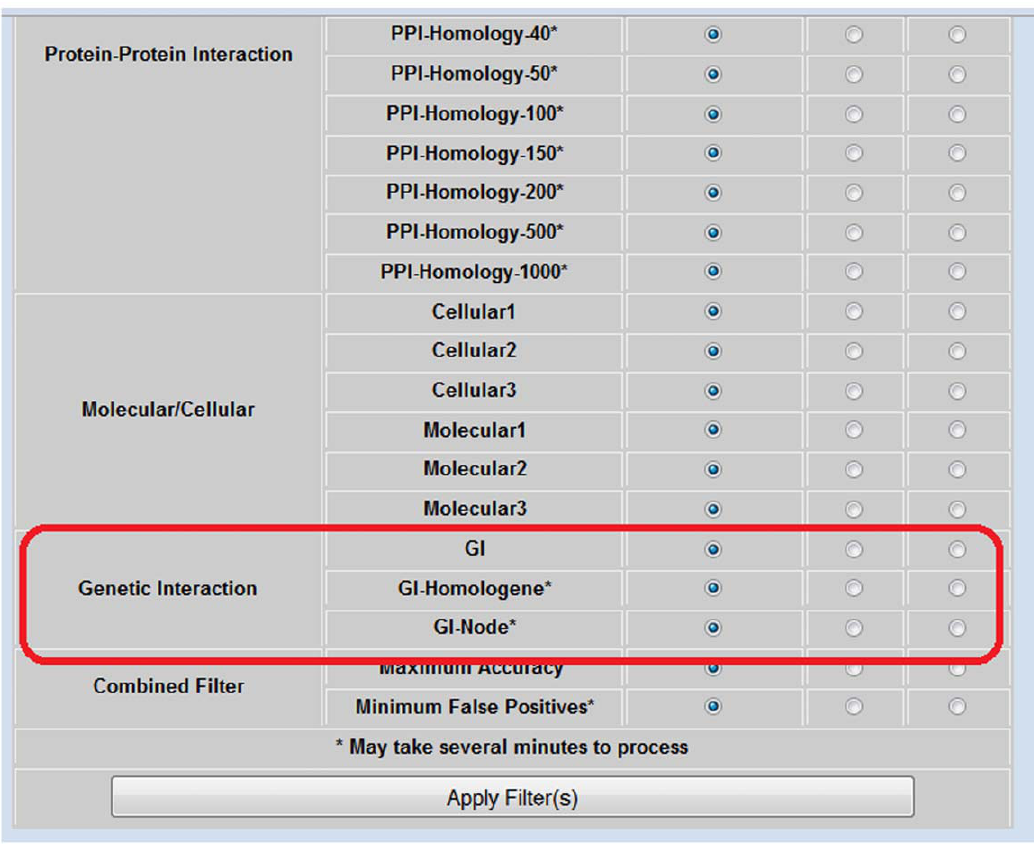
Figure 2. Screen Shot of Minimotif Miner 2.4 filter menu. GI filters were added as part of MnM website 2.4 located under the motif filter pull down section. The options for filtering with ‘GIs’ are outlined with a red box. This filter can be used on its own or in combination with filters. There are also options to check boxes to include or exclude minimotifs with GIs.